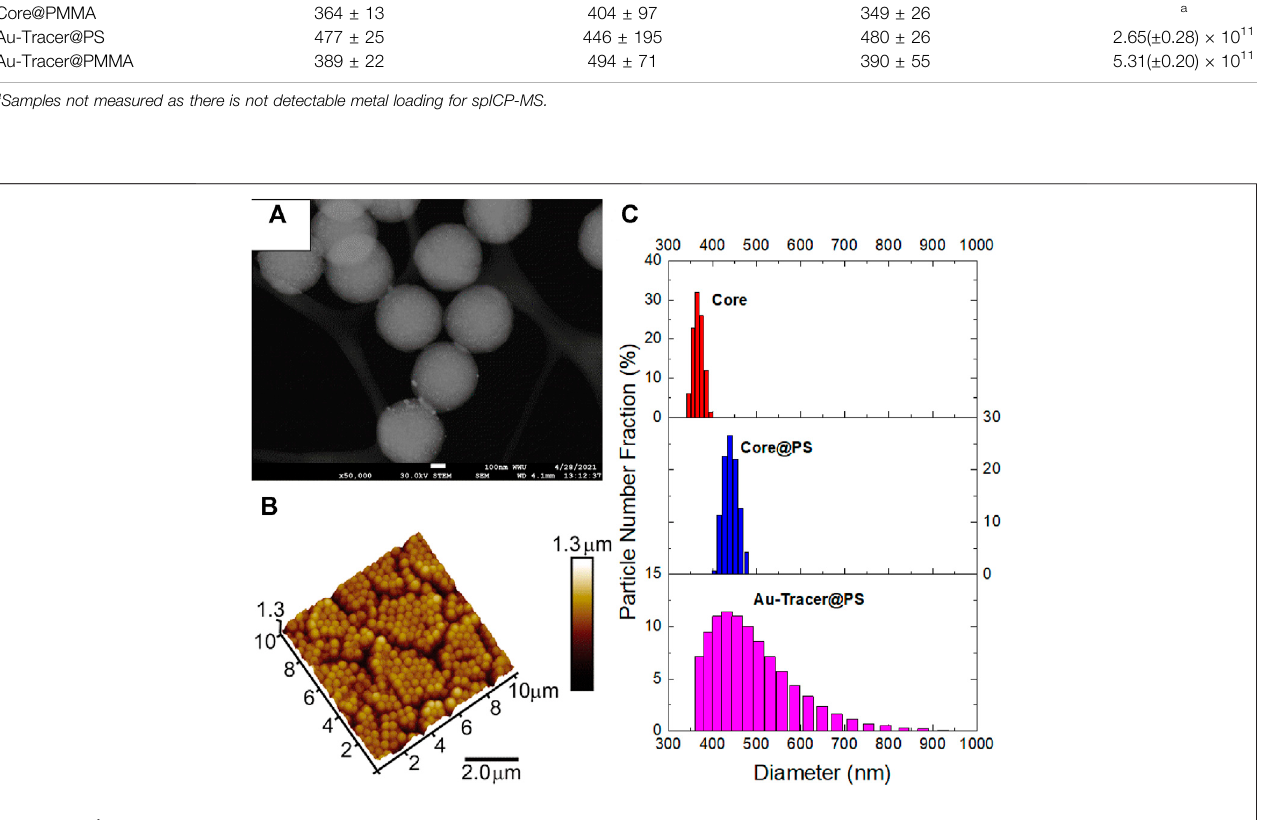
Frontiers in Toxicology |